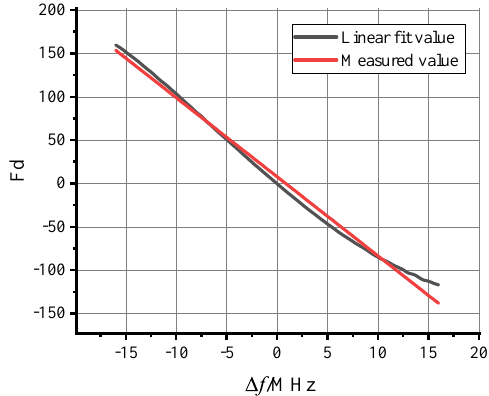
Figure 8. The relationship between the output result of the frequency real-time calculation module and the measured signal